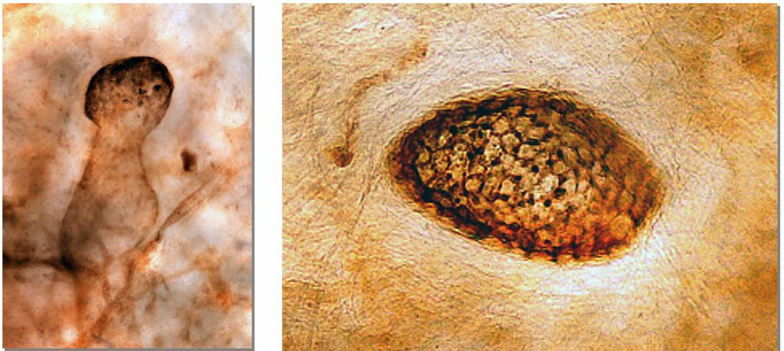
Figure 8. Blind loop of submesothelial lymphatic vessels (initial lymphatic vessel, stained with 5 (cid:48) -Nase enzyme) containing activated carbon (CH44) that was intraperitoneally injected ( left ). CH44 is attached between the lymphatic endothelial cells ( right ). (Pelvic peritoneum). The lymphatic vascular system of the diaphragm is slightly different from that of the pelvis and Morrison’s pouch. On the abdominal surface of the diaphragm, the openings in the mesothelium that connect it with the submesothelial lymphatic vessels (initial lymphatic vessels) are defined as lymphatic stomata, whereas unattached mesothelial gaps to the initial lymphatic vessels are not defined as lymphatic stomata (Figure 9C). Negative pressure due to inspiration helps to absorb peritoneal fluid and macro molecules through the lymphatic stomata of the diaphragm, and the absorbed materials migrate in the lymphatic vessels, which vertically run through diaphragmatic muscle (Figure